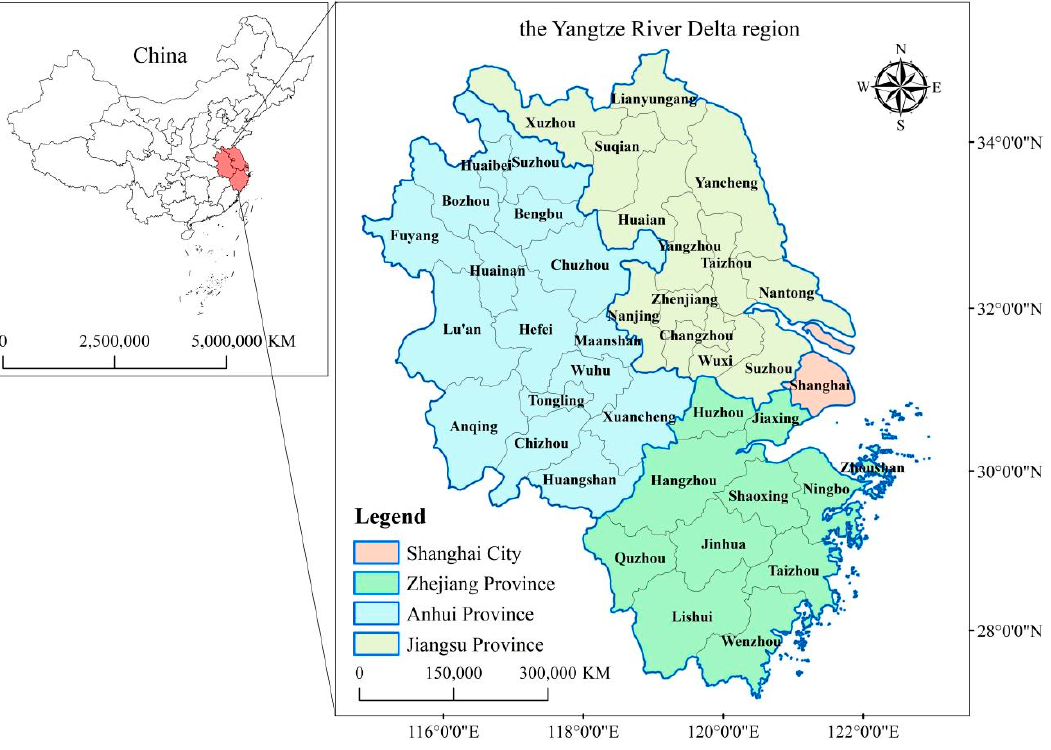
Figure 1. Overview of the study area.